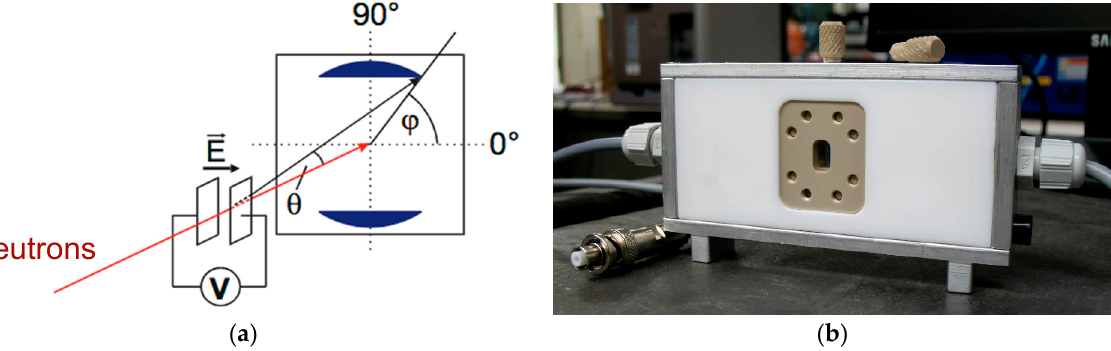
Figure 10. Electric field setup used for on-line SANS experiments [89]. Schematic drawing of experimental setup ( a ). Capacitor dedicated for small-angle neutron scattering experiments of polymer solutions ( b ). The capacitor consists of gold electrodes and its interior parts are mantled in Teflon.